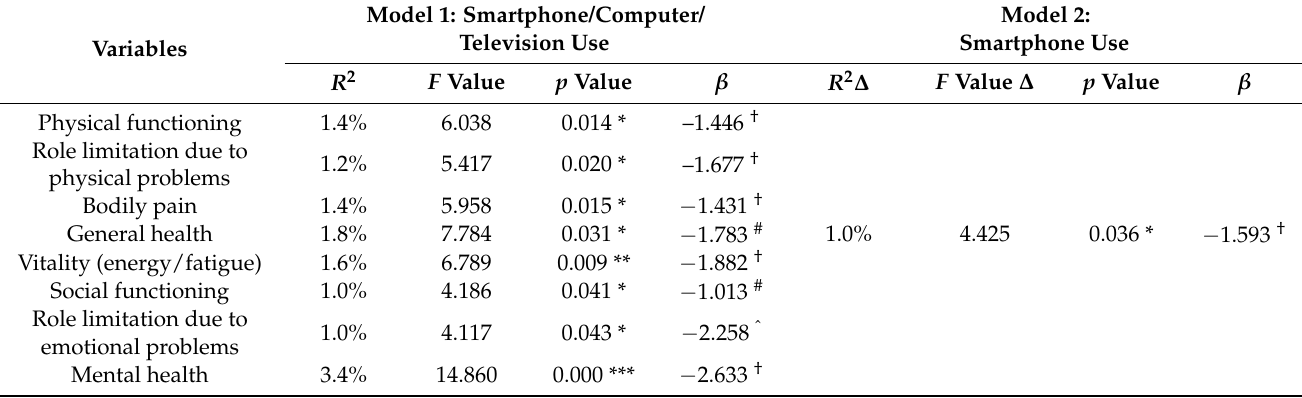
Table 2. Summary of the stepwise multiple linear regressions of the durations of smartphone, computer, and television use as predictors of the physical and mental domains of SF-36 in early male adolescents during COVID-19 ( n = 430).